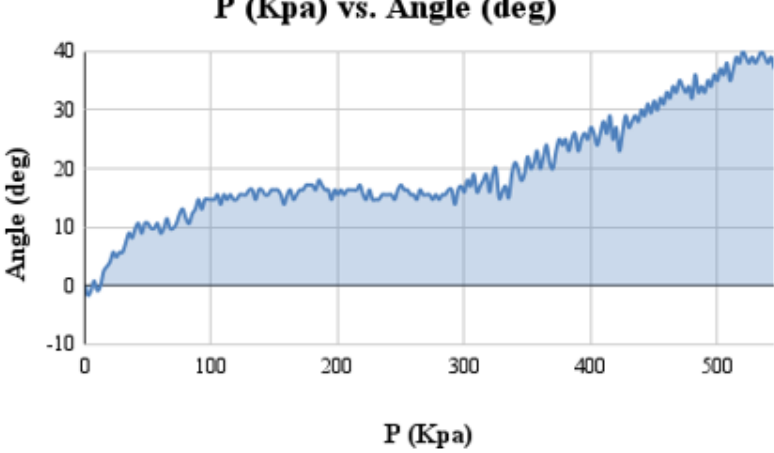
Figure 6. Relation between input pressure and bending sensor readings.